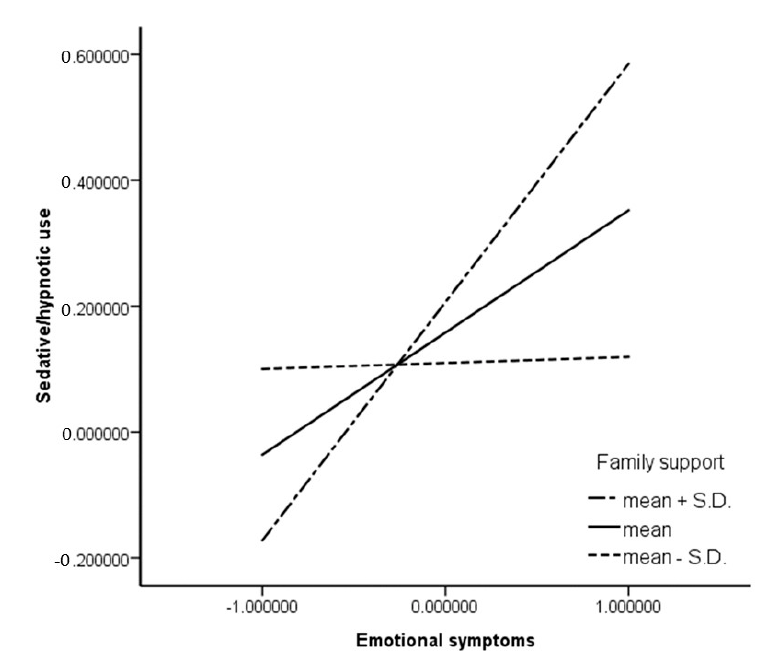
Figure 3. Distribution plots for three different effects of moderation.